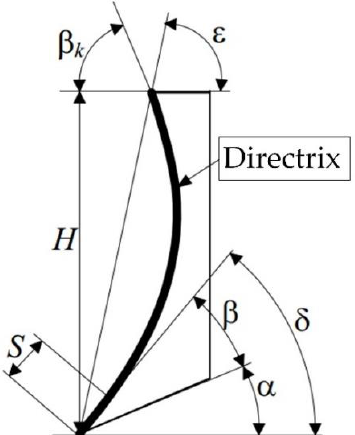
Figure 7. Longitudinal section structure parameters of the bulldozing plate.